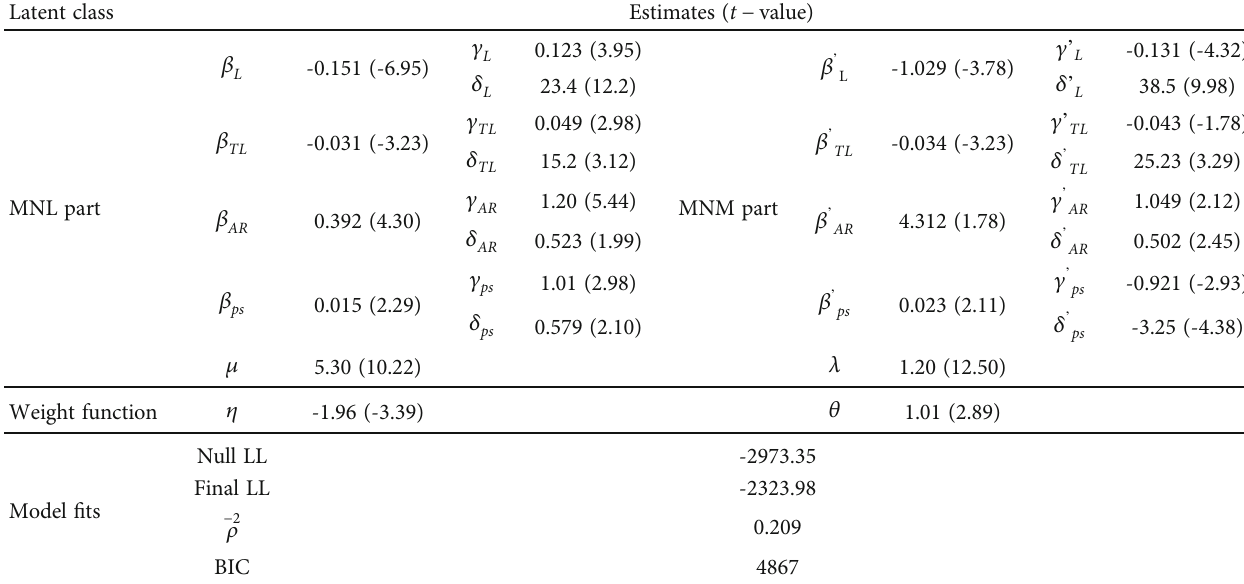
Table 2: Estimation